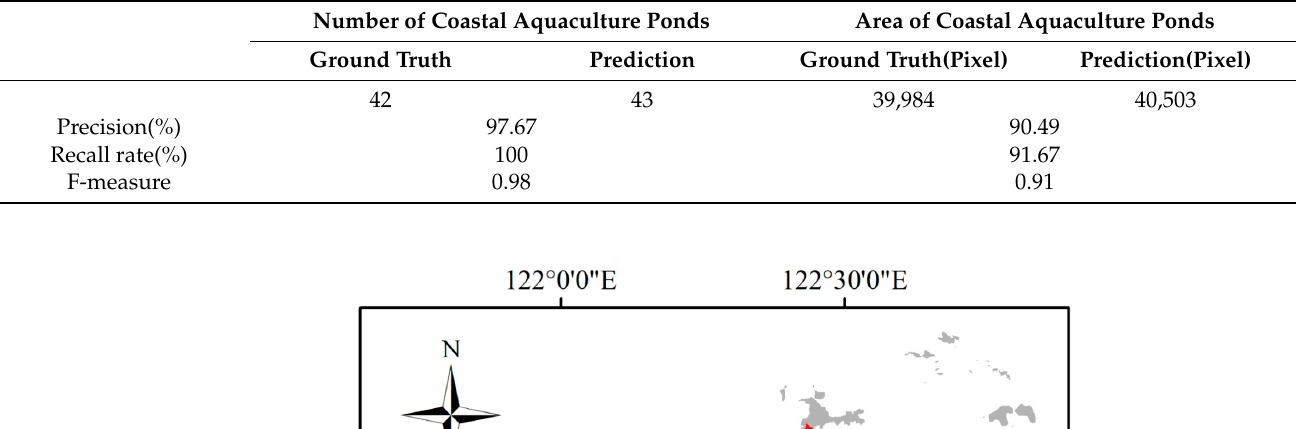
Table 5. Accuracy evaluation of coastal aquaculture ponds extraction in the Zhoushan Archipelago, China.